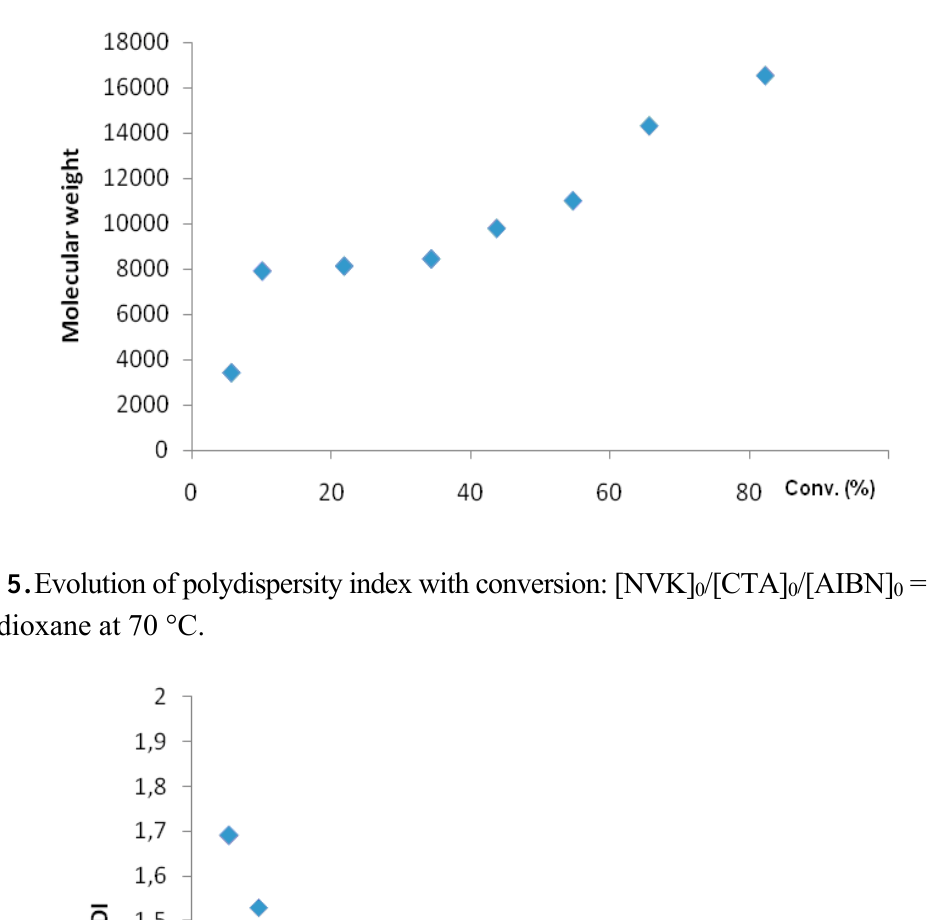
Figure 4. Evolution of experimental molecular weight with polymerization yield